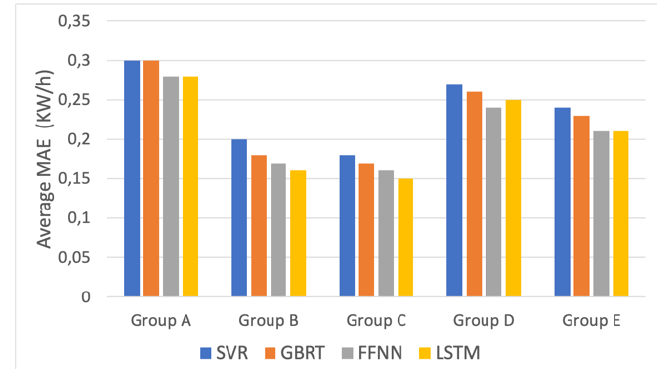
Figure 10. Comparison of models based on average Mean Absolute Error (MAE) per customer group.